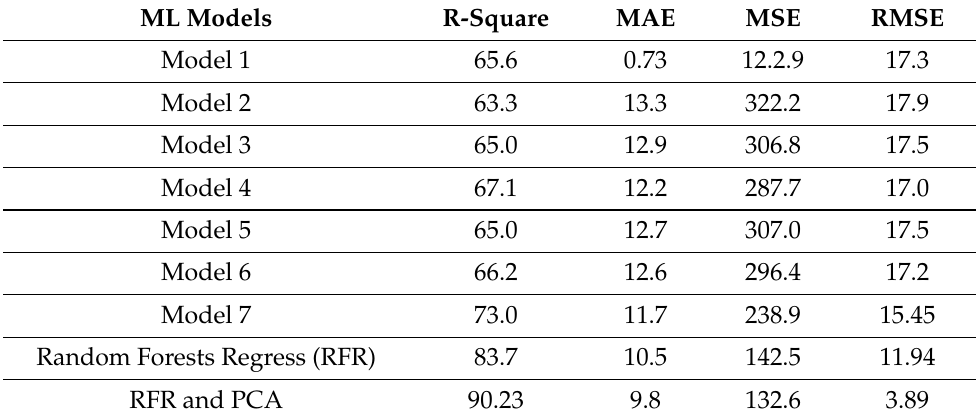
Table 3. Frequency bands prediction evaluation metrics.